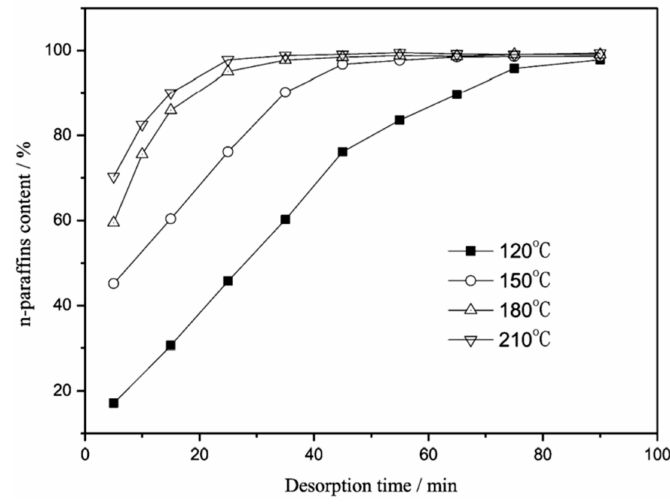
Figure 2. The content (%) of n-alkanes in the desorbed liquid at different temperatures [35].